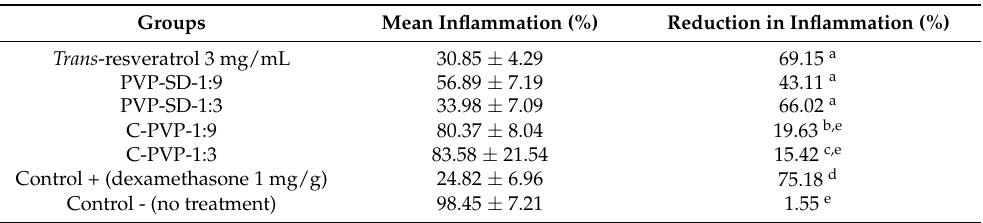
Table 8. Inflammation and inflammation reduction results. Equal letters indicate no statistically significant difference between the samples (Tuckey test, p > 0.05).